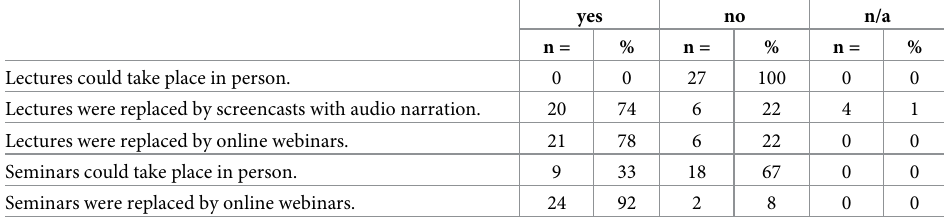
Impact of the COVID-19 pandemic on teaching in lectures/seminars, on clerkships, and on the final year at German university hospitals